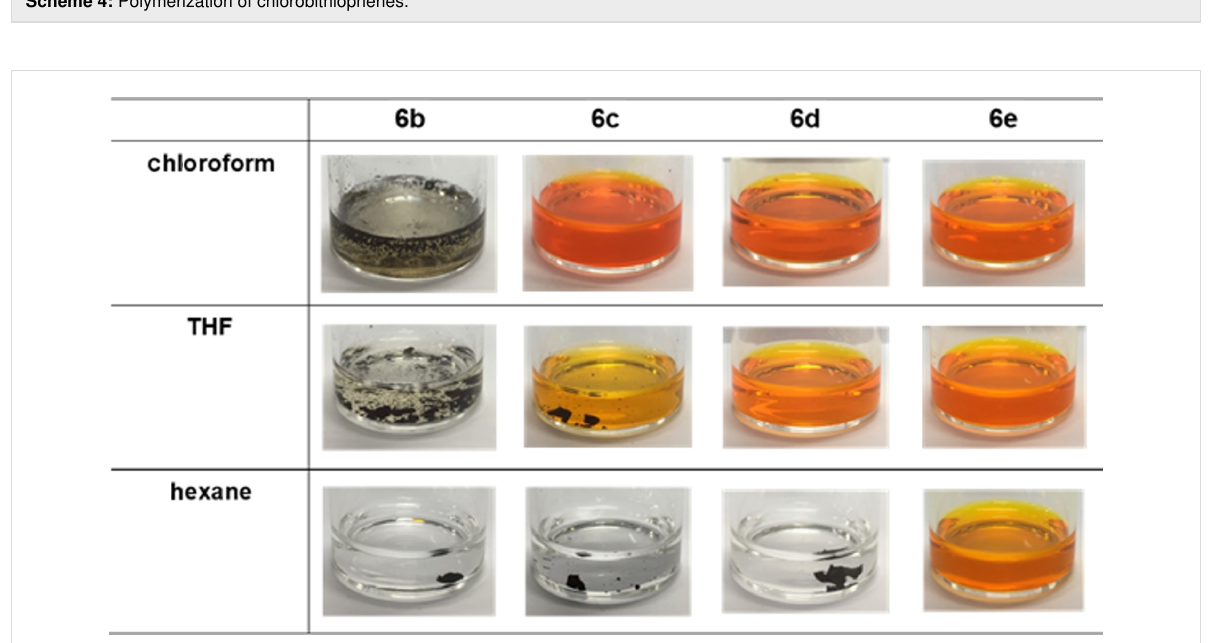
Figure 1: Solubility tests of alternating copolymer 6 (1 mg of material dissolved in 1 mL of the